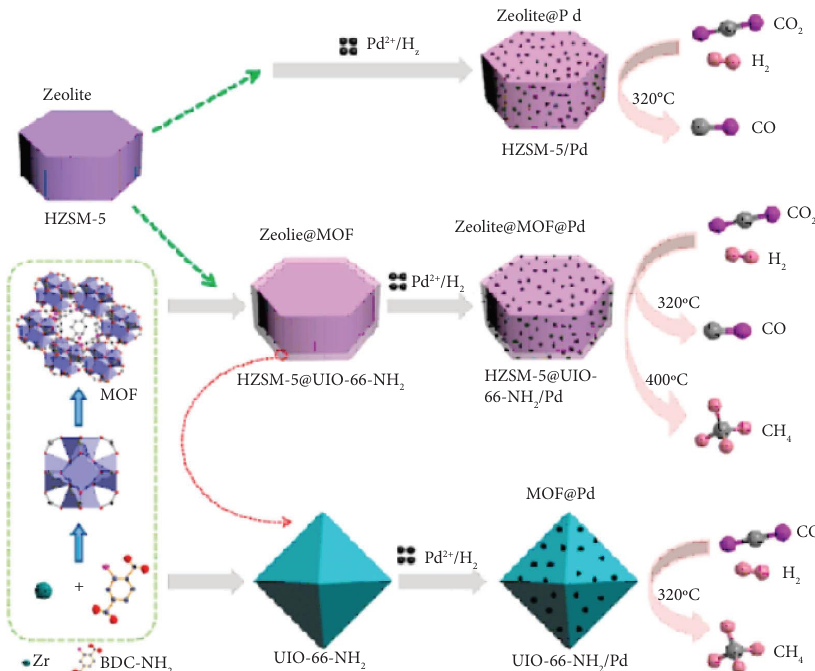
Figure 30: Synthesis of HZSM-5@Pd, HZSM-5@UIO-66-NH 2 @Pd, and UIO-66-NH 2 @Pd for hydrogenation of CO 2 adopted from